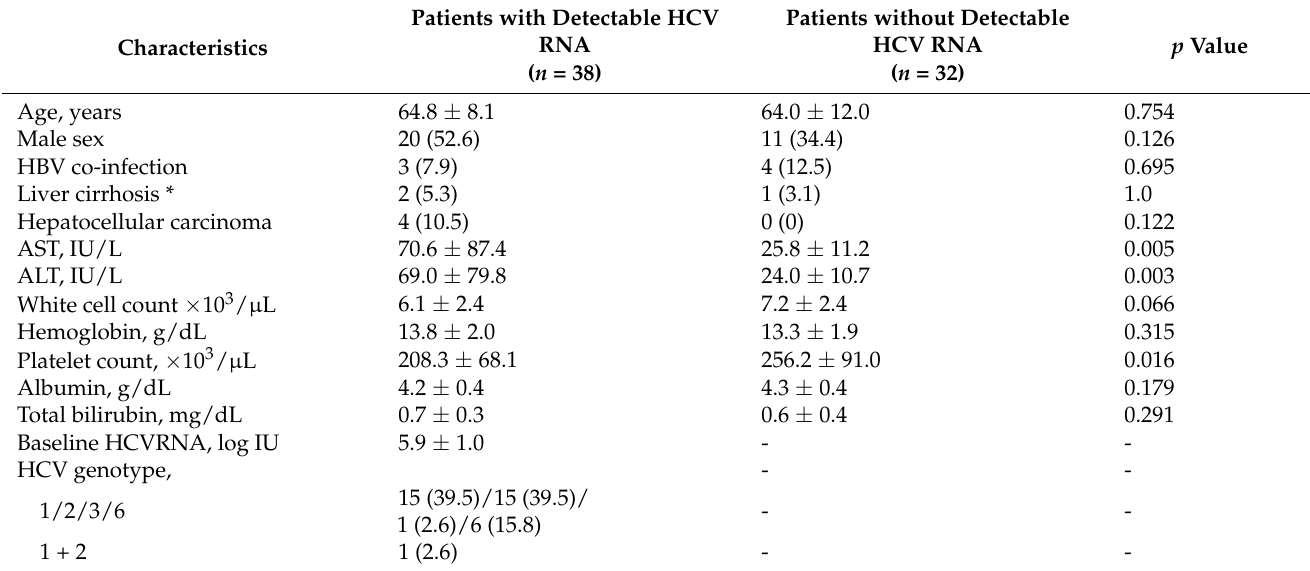
Table 2. Characteristics of 70 HCV-infected subjects with successful referral.